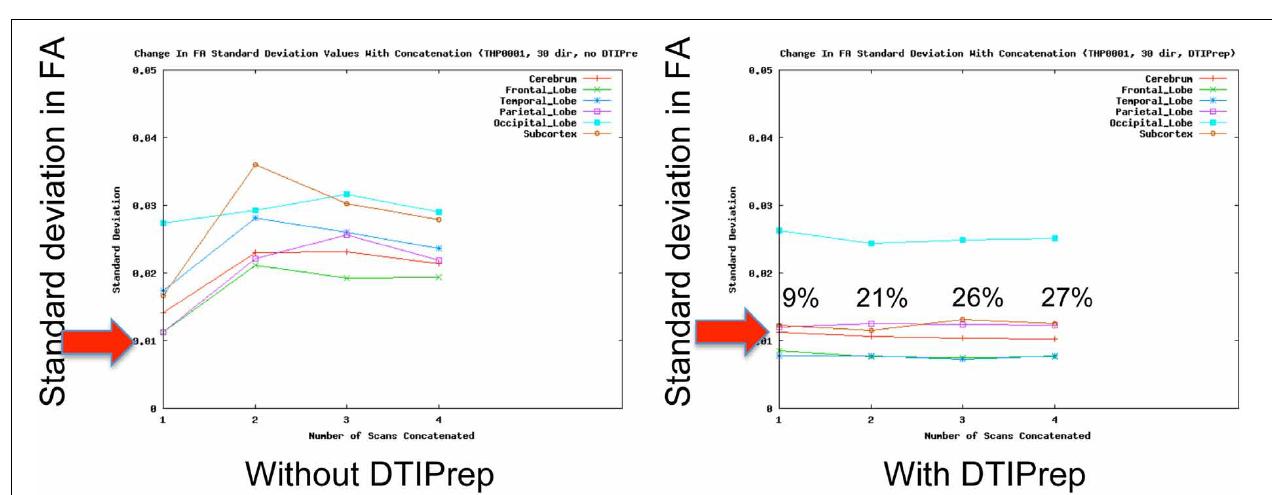
FIGURE 3 | QC reduces measurement noise in DTI. Standard deviation of FA in five healthy subjects in six regions are shown. QC reduces FA standard deviation considerably even for a single scan; the improvement is dramatic